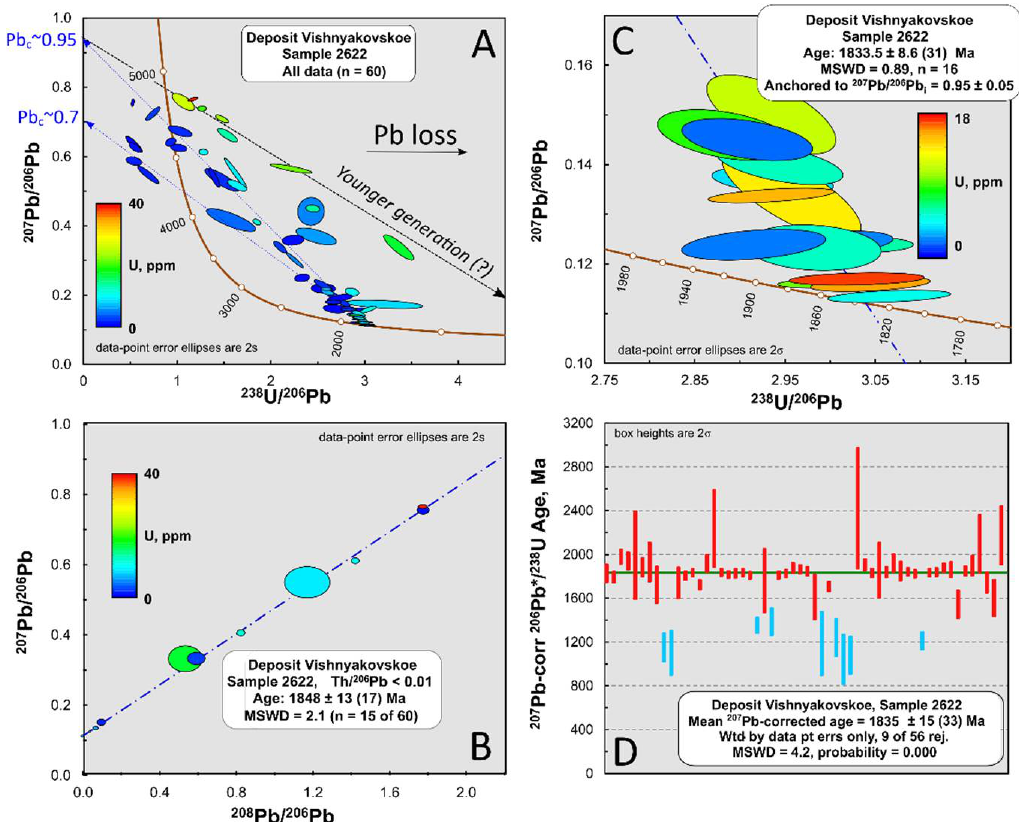
Figure 10. The U-Pb isotope data for a cassiterite sample from the Vishnyakovskoe rare metal deposit, East Sayan. Tera-Wasserburg isochron diagrams for all spot analyses ( A ) and analyses showing the most radiogenic Pb-isotope compositions ( C ). An inverse Pb-Pb isochron ( B ) and a weighted average of the 207 Pb-corrected 206 Pb*/ 238 U ages ( D ) are also shown. The vertical lines in ( D ) represent age values with 2 standard error (2 SE) bars. The blue lines are outliers not included in the weighted average calculation.